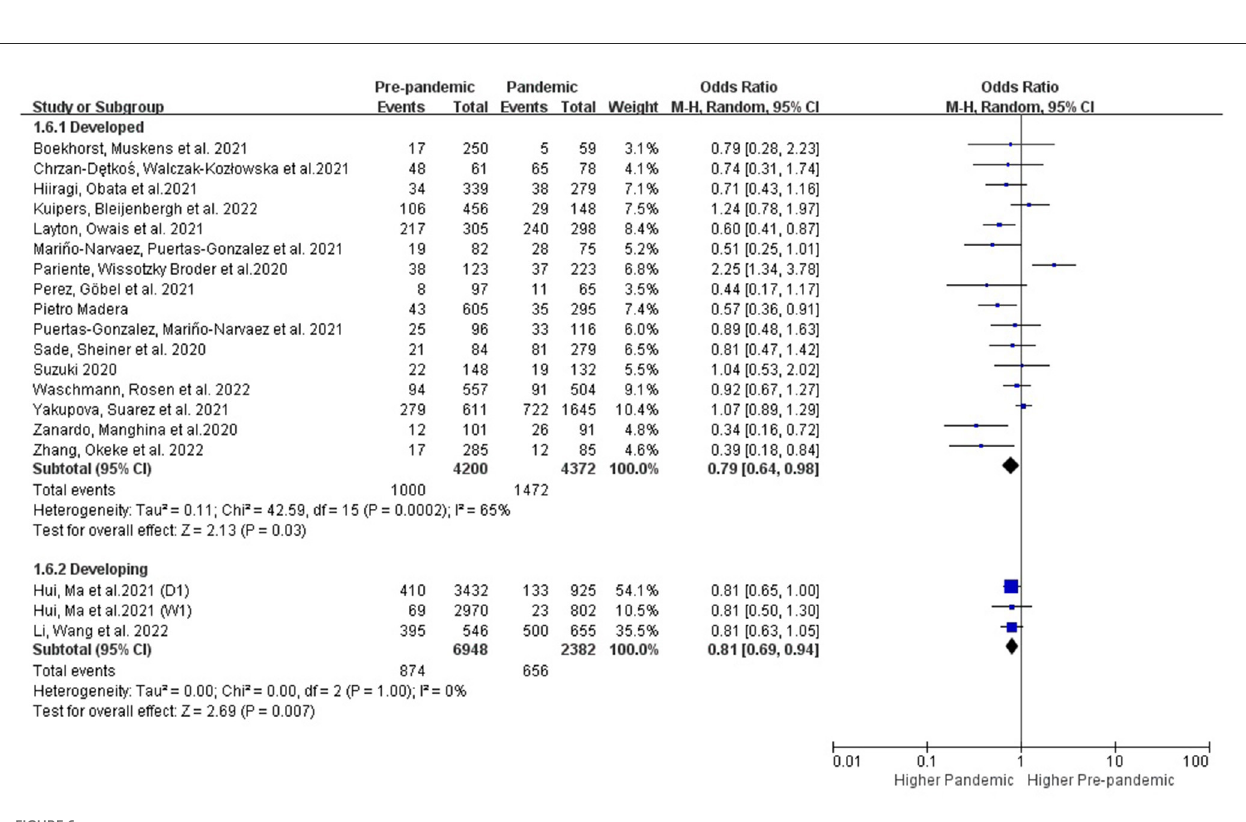
FIGURE6 Subgroup analysis comparing the prevalence of PPDS before and during the COVID-19 pandemic according to different country